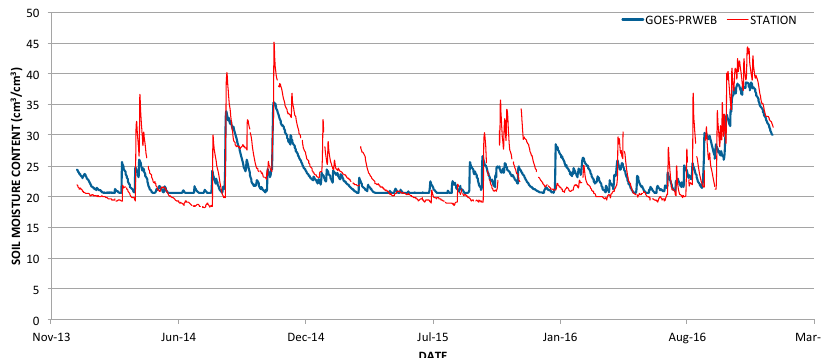
Figure 6. Estimated and measured (depth-averaged) θ at the Fortuna Agricultural Experimental